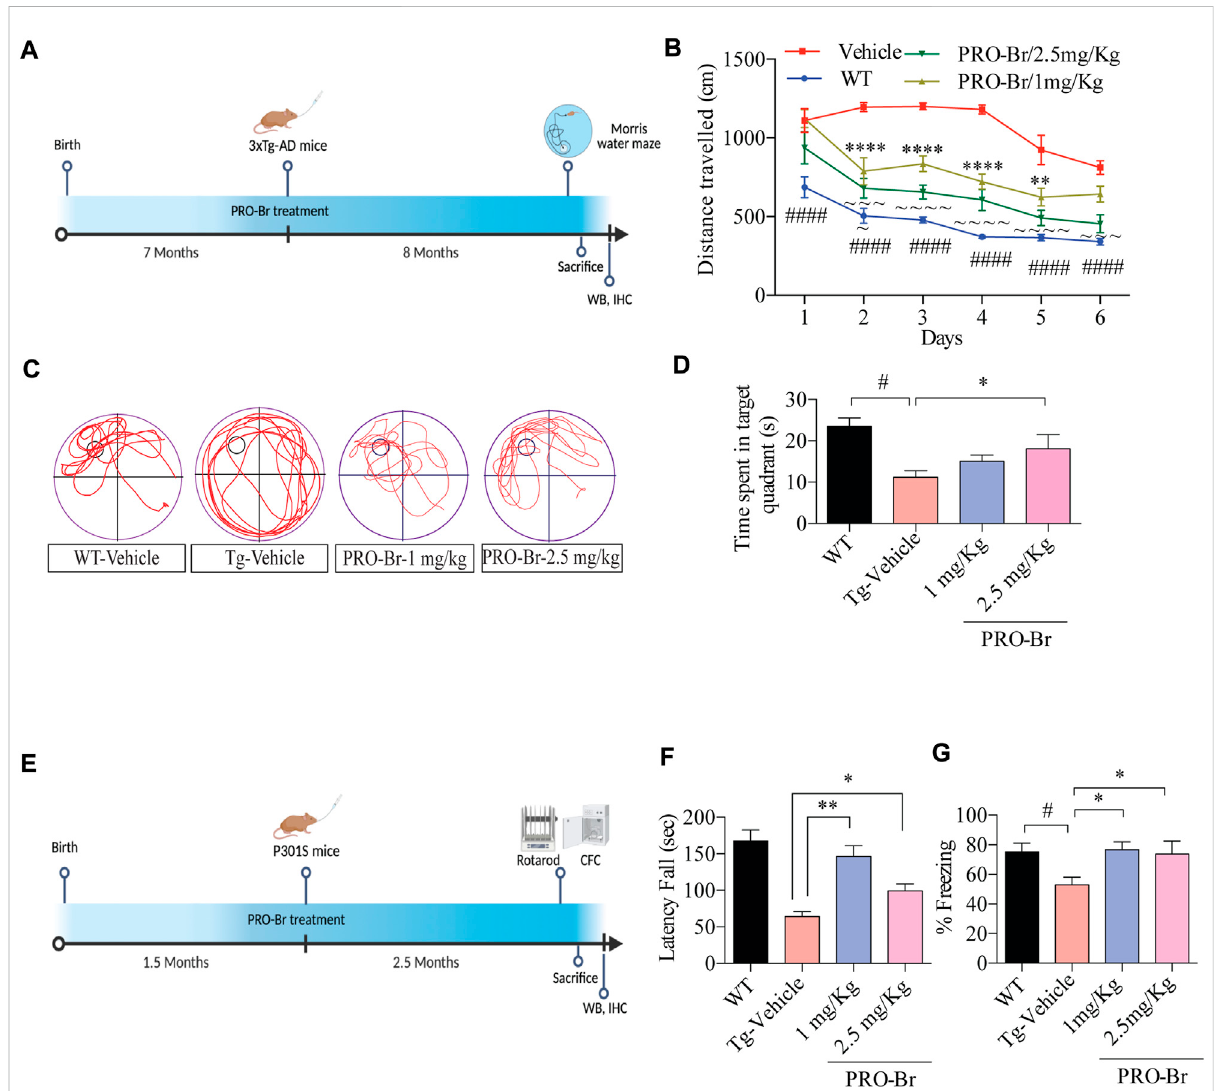
FIGURE 2 PRO-Br alleviates cognitive impairment in AD mice models (A) Schematic timeline of PRO-Br treatment and behaviour schedule in 3xTg-AD mice model. (B) PRO-Br improved memory function according to the Morris water maze test for WT-Vehicle, Tg-Vehicle-, and PRO-Br-treated groups (1 and 2.5 mg/kg) (C) Representative images of path-lengths traversed by the mice of all groups to reach the target quadrant. (D) Probe test shows the time spent by animals in the target quadrant (E) Schematic timeline of PRO-Br treatment and behaviour schedule in P301S mice model. (F) PRO-Brtreatmentincreasedthemotorfunctionsintherota-rodassayand (G) increasedthefreezingtimeandimprovedthehippocampal memory functions in CFC assay in the P301S mice